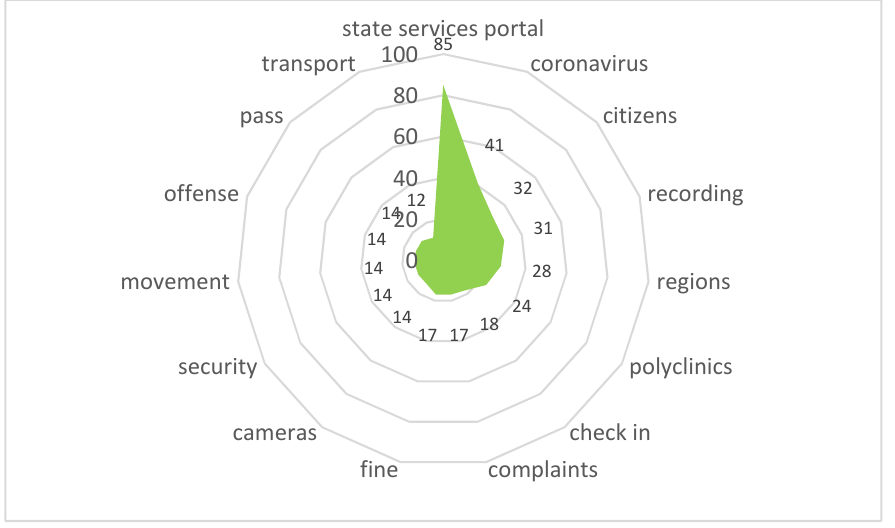
Figure 20. Associative network for stimulus Government Services.